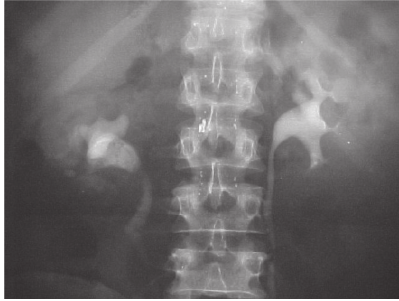
Figure 2 - Intravenous urogram after contrast enhancement demonstrating an intrarenal pelvic calculus.